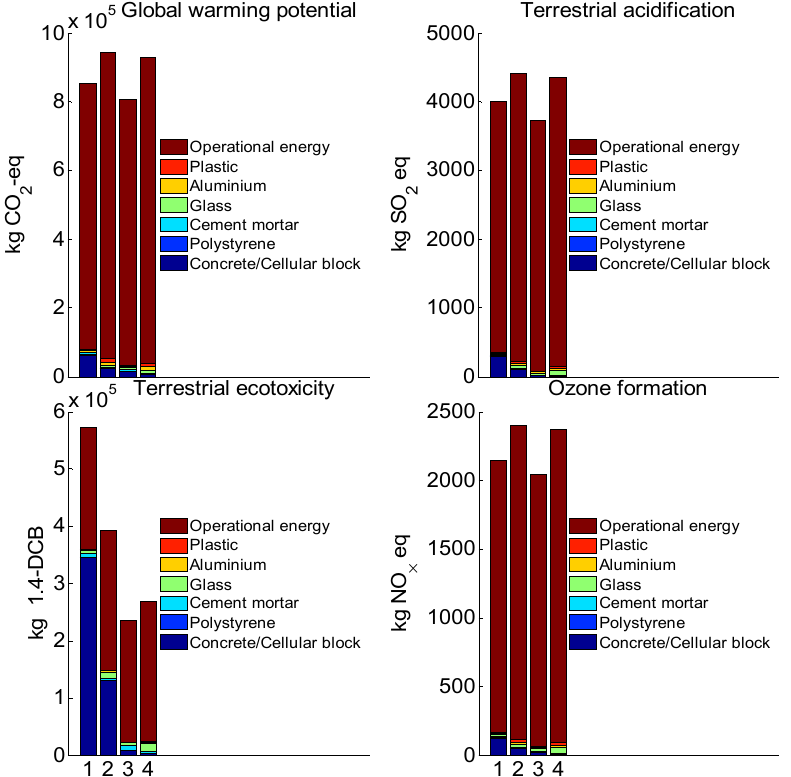
Figure 4. P&R and OE stages (OE stage with 31% coal + 56% gas + 13% PV-based electricity): environmental impact of CB MinWin (1), CB MaxWin (2), AAB MinWin (3), and AAB MaxWin (4), evaluated with ReCiPe2016 midpoint method, hierarchist (H) methodological option.